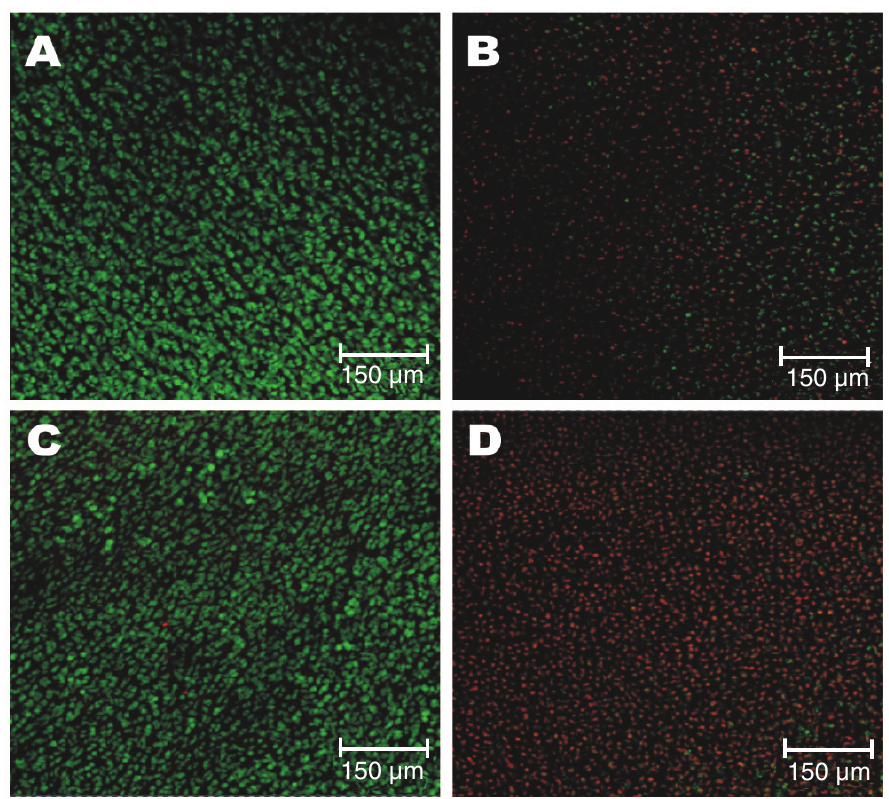
Figure 2. Three-dimensional confocal reconstructions of z stacks through cartilage explants (15μm sections) after five days in culture. Control ( A ) consists of culture media with 2% penicillin/streptomycin. Sodium nitroprusside (SNP) (50mM) ( B ) is a positive control for cell death. Treatments consist of curcumin in culture media at 25μM ( C ) and 100μM ( D ). Images are representative of explants in the treatments wells for each animal. Green staining indicates live metabolizing cells and red staining highlights the nuclei of dead cells. Data are from 3 different animals, with one technical replicate per